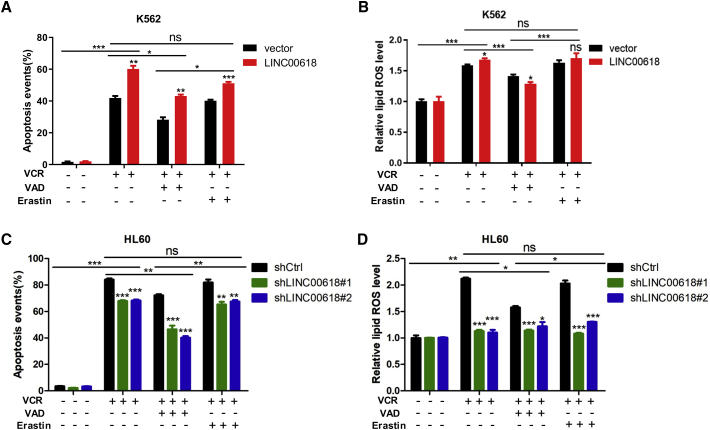
LINC00618 Accelerates Ferroptosis in Dependence of Apoptosis(A) Flow cytometry and statistical analysis of apoptosis level in K562 cells stably overexpressing LINC00618 with VCR, VAD, and erastin treatment. (B) Flow cytometry and statistical analysis of relative lipid ROS level in K562 cells stably overexpressing LINC00618 with VCR, VAD, and erastin treatment. (C) Flow cytometry and statistical analysis of apoptosis levels in HL60 cells after the knockdown of LINC00618 with VCR, VAD, and erastin treatment. (D) Flow cytometry and statistical analysis of relative lipid ROS levels in HL60 cells after the knockdown of LINC00618 with VCR, VAD, and erastin treatment. Data are shown as the mean ± SEM; n ≥ 3 independent experiments, two-tailed Student’s t test: ns, nonsignificant (p > 0.05), ∗p < 0.05, ∗∗p < 0.01, ∗∗∗p < 0.001.